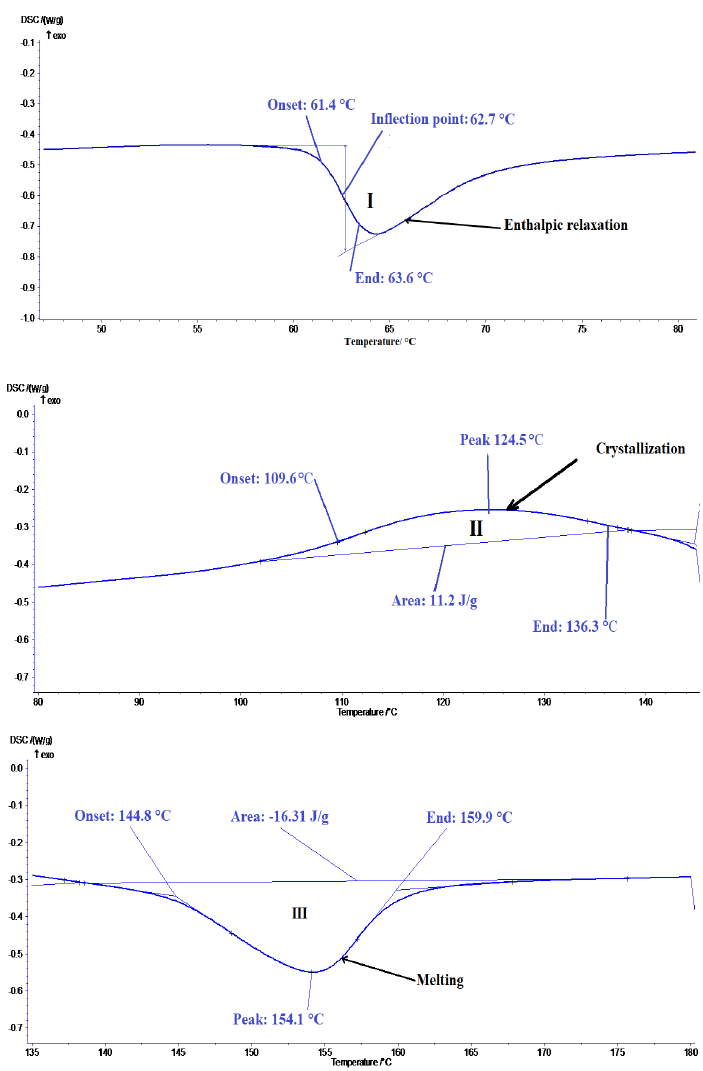
Figure 14. Highlighting the main thermal behavior of the printed Extrudr BDP Flax samples. Table 9. Summary of data evaluation with Proteus software.